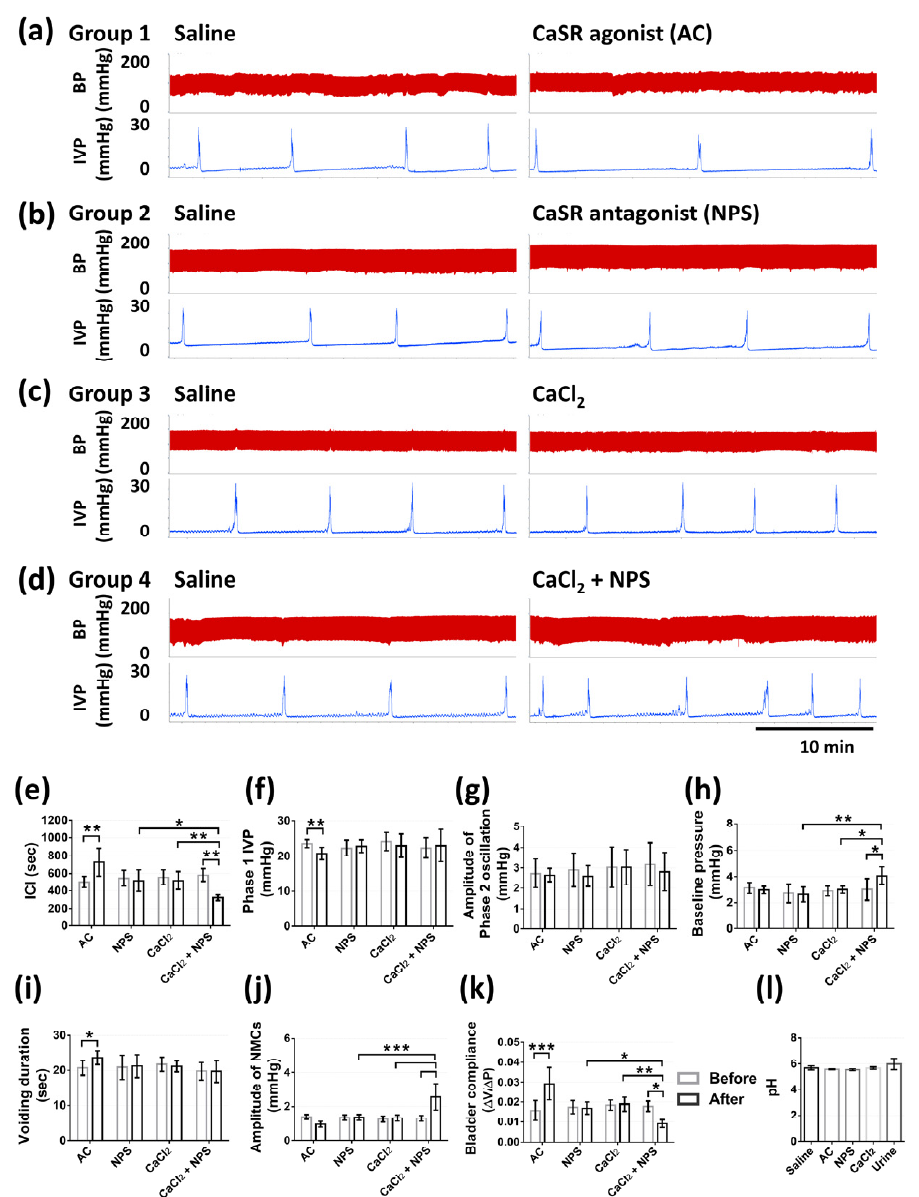
Figure 5. The effects of CaSR agonist (AC), CaSR antagonist (NPS), CaCl 2 , and CaCl 2 containing NPS on micturition. Effects of intravesical administrations of 1 mM AC ( a ), 1 mM NPS ( b ), 20 mM CaCl 2 ( c ), and 20 mM CaCl 2 containing 1 mM NPS (CaCl 2 + NPS) ( d ) on micturition with the recording of IVP and BP. The statistical analysis of micturition function parameters before (saline) and after different treatments, including ICI ( e ), phase 1 IVP ( f ), amplitude of phase 2 oscillation ( g ), baseline pressure ( h ), voiding duration ( i ), amplitude of NMCs ( j ), and bladder compliance ( k ). The statistical analysis of pH values of solutions for intravesical infusion and urine from rats ( l ) (Two-way ANOVA with Sidak’s post hoc tests, n = 6 for each group; * p < 0.05, ** p < 0.01, *** p < 0.001, as compared with saline treatment in each group or among different